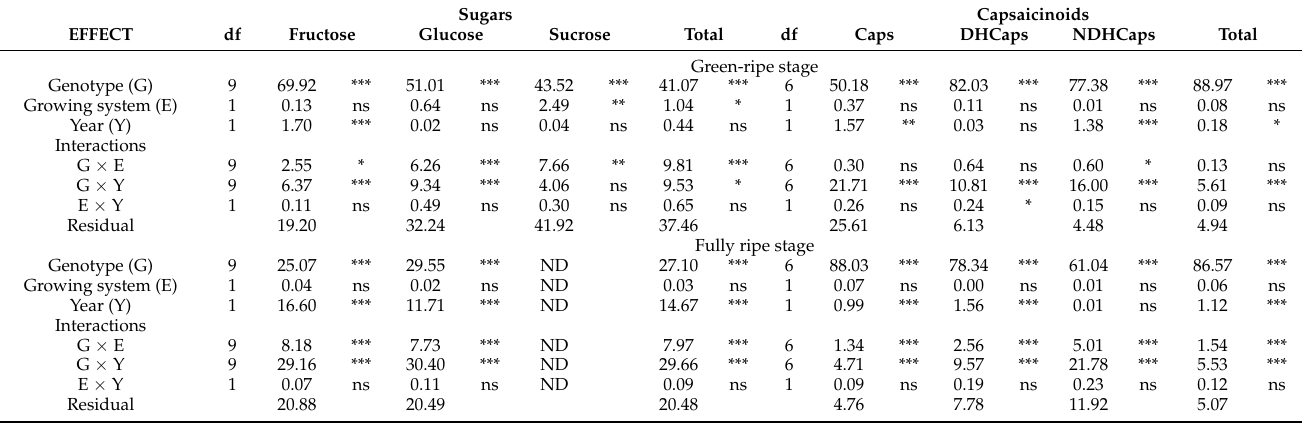
Table 2. ANOVA’s total sum of squares (expressed in %) for the effects of the genotype (G), growing system (E), and year (Y), and their interactions for the content in sugars: fructose, glucose, sucrose, and total, and capsaicinoids: capsaicin (Caps), dihydrocapsaicin (DHCaps), nordihydrocapsaicin (NDHCaps), and total, considering separately green-ripe and fully ripe